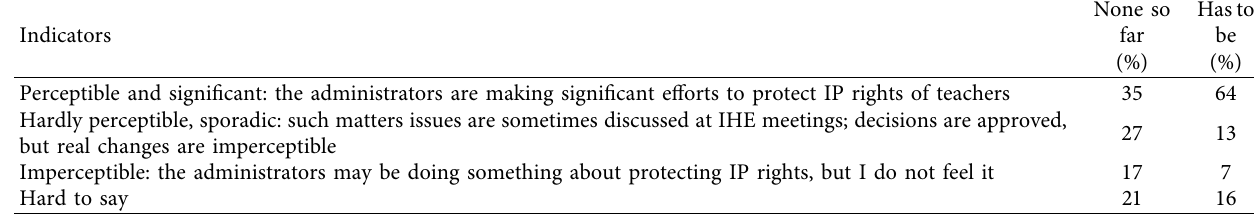
Table 11: Role of administrators of educational institutions in IPR protection management.